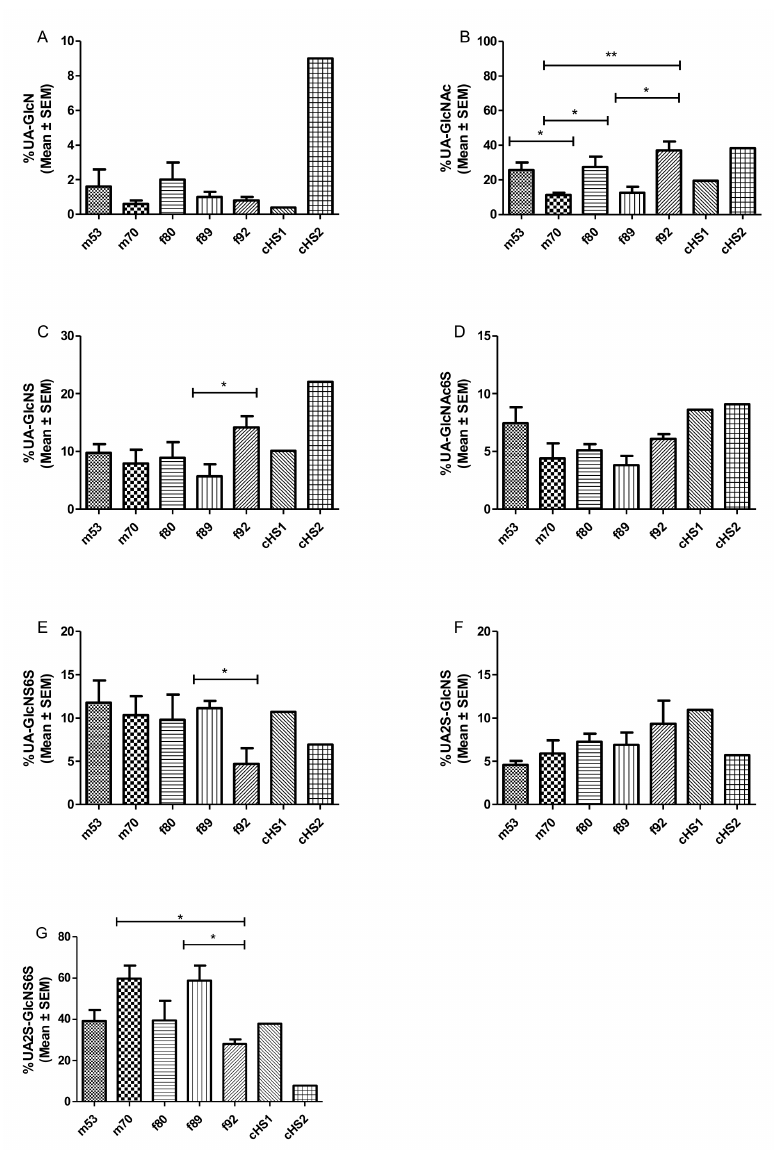
Figure 3. ( A – G ) Relative molar abundance (in percentage) of disaccharide composition of the different HS preparation from donor’s lungs, derived by SAX-HPLC, depicted as mean ± SEM. Data sets were compared using Student’s t -test. * p < 0.05, ** p < 0.01 was considered as statistically significant. (f refers to females, m to males, t to tumor lobe, and the number represents the donor’s age). Mean ( ± SEM) was calculated from three independent SAX-HPLC runs. The obtained AUCs were measured for each peak and compared with AUCs of commercially available HS disaccharide standards